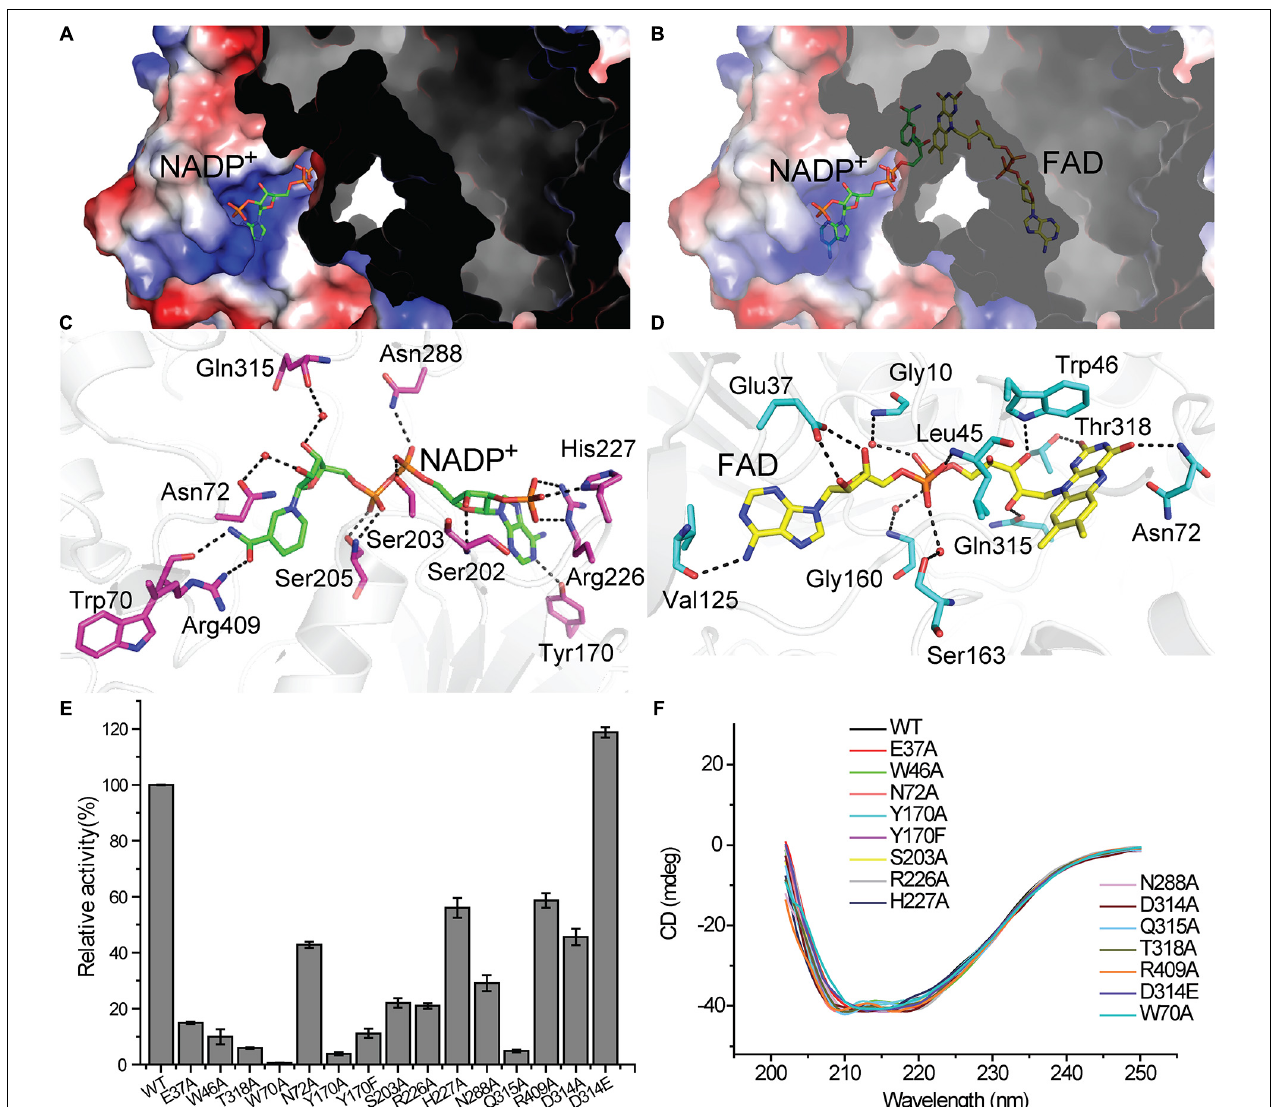
FIGURE 3 | The binding of the NADP + molecule and the FAD molecule in Tmm 7211 . The NADP + molecule and the FAD molecule are shown as sticks colored in green and yellow, respectively. (A) Electrostatic surface of Tmm 7211 . The NADP + molecule is partially visible through the surface. (B) Electrostatic surface of Tmm 7211 after the transparency of surface was set to 40%. (C) Interactions between NADP + and Tmm 7211 residues. (D) Interactions between FAD and Tmm 7211 residues. Water molecules are shown in red dots. The possible hydrogen bonds are represented by dashed lines. (E) The enzymatic activities of WT Tmm 7211 and its mutants. The activity of WT Tmm 7211 is taken as 100%. The standard errors are from three independent experiments. (F) CD spectra of WT Tmm 7211 and its